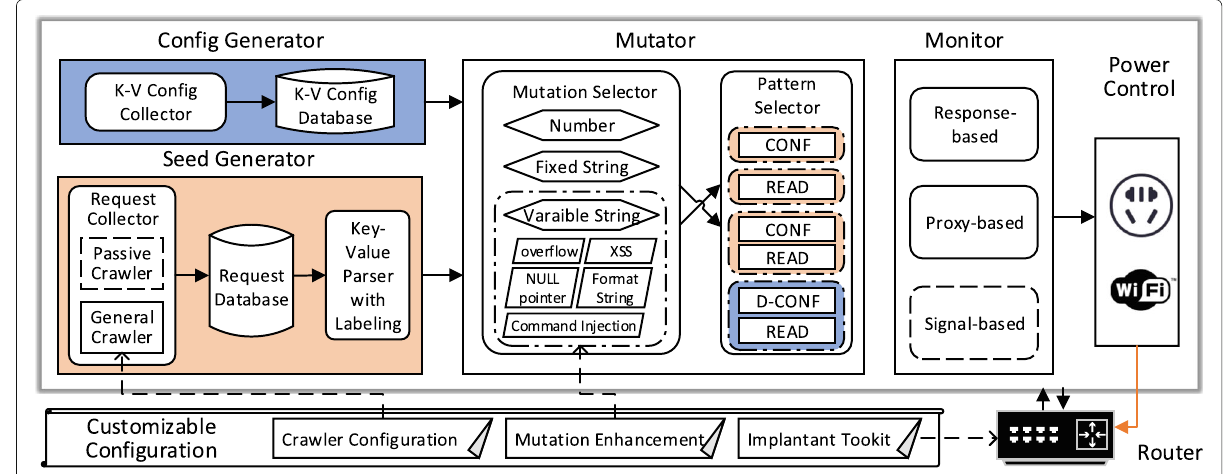
3. Mutator. The Mutator generates mutated requests and triggers vulnerabilities for the SOHO router through the cooperation of two submodules, i.e., the Mutation Selector and the Pattern Selector. Guided by the K-V model, mutation rules are selected and applied to the value of each k-v pair, according to the attributes of the k-v pair and the